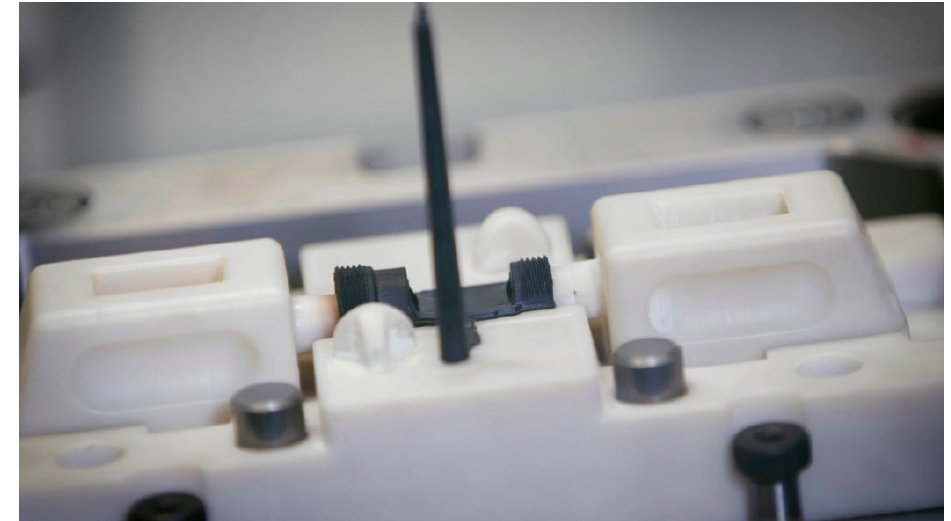
Figure 6. In ‐ process injection molding with soft tooling with slides. Figure 6. In-process injection molding with soft tooling with